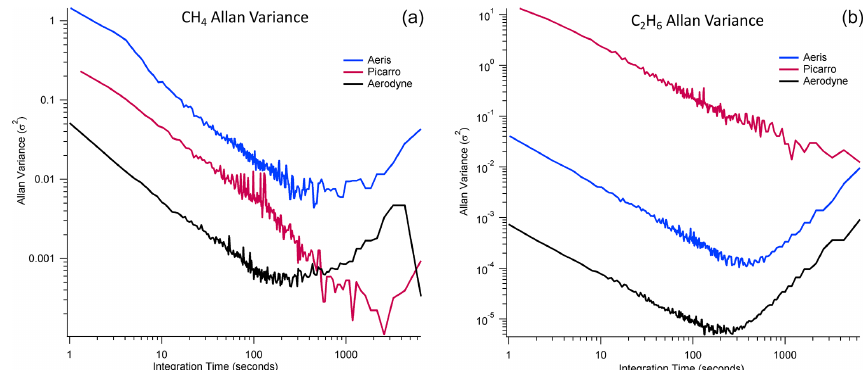
Figure 2. Allan–Werle variance for (a) methane and (b) ethane for all three instruments when sampling a compressed-air cylinder on 17 February 2022 at 11:00am–03:00pm EDT. Each of the tanks was calibrated to NOAA cylinders after water vapor correction. The reported water vapor for the Aerodyne SuperDUAL (black) was below 0.054%. The Aeris MIRA (blue) and Picarro G2210-i (red) were humidified to water vapor